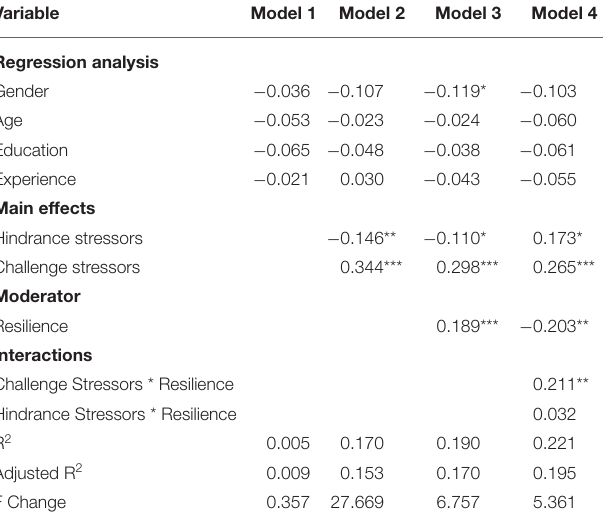
TABLE 6 | Moderation analysis.